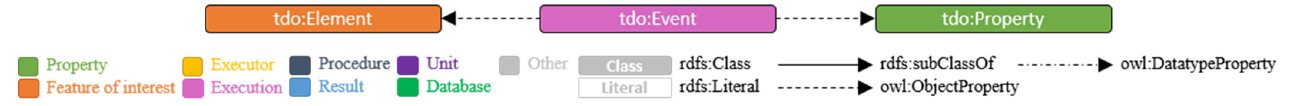
Figure 8. The TDO pattern extends eep:Execution with tdo:Event.